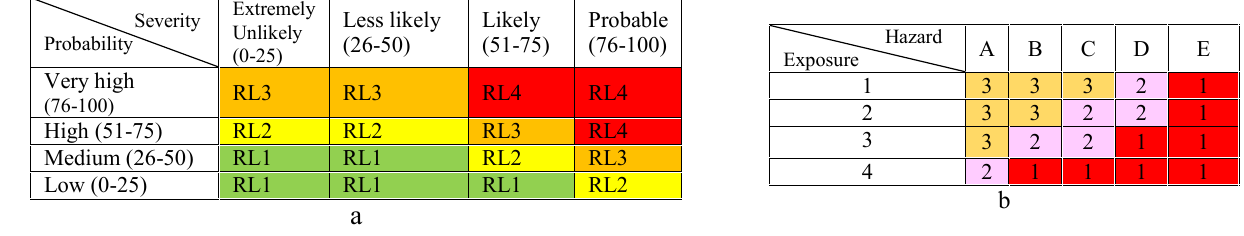
Fig. 8. Control Banding Nanotool matrix (a) and Stoffenmanager Nano matrix